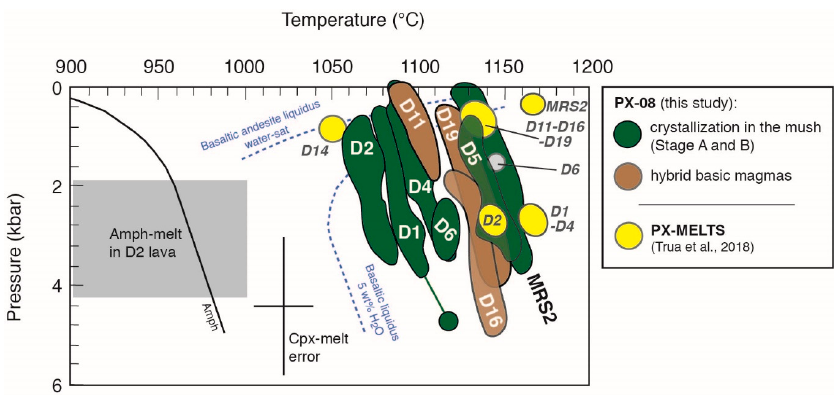
Figure 4. Plots of TiO 2 (wt%) versus Mg# for the clinopyroxene cargoes in the D16 basalt, and D11 and D19 basaltic andesites. These are hybrid basic lavas erupted at the MV south-eastern flank (Figure 1a). Note that these cargoes display a similar chemical variability, irrespective of the chemistry of the carrier lava, that covers most of the D5 and D2 fields. The crystals are tagged as in Figure 2; further photomicrographs are reported in Supporting Materials (Figures S3 and S4). Only in these lavas, partially resorbed clinopyroxene crystals (Cpx res) and gabbroic clots with open, sub-circular texture (Enclave) were found. Analytical error, yellow box and vertical band are displayed as in Figure 2. Light and dark green fields represent D2 and D5 clinopyroxenes, respectively, recording Stage A and Stage B crystallization in the deep MV mush.